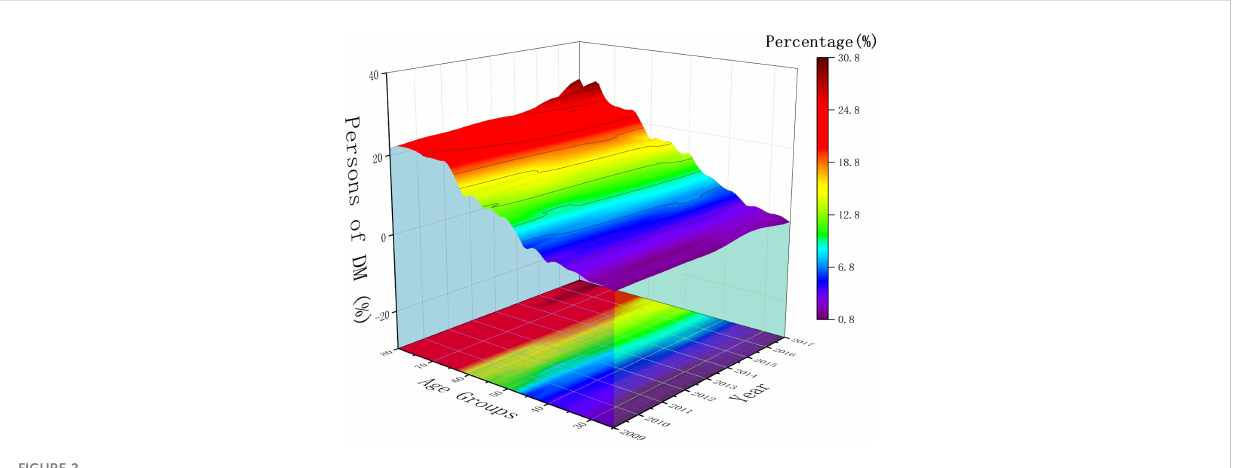
FIGURE 2 The trend of diabetes incidence from 2009 to 2018 by age groups and